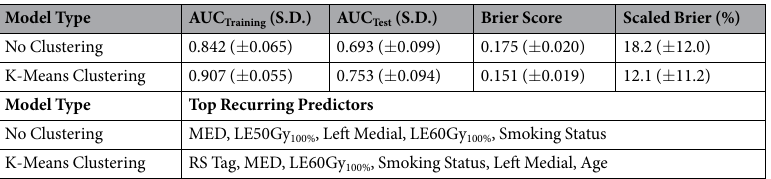
Table 3. Results of the lasso logistic regression toxicity prediction model construction process with and without using K-Means clustering to identify radiosensitive patients, from expansion-response quantified at the end of radiation therapy, for a total of 126 study patients. S.D. – Standard Deviation. The highest recurring predictors from all 1000 iterations of the model construction process are listed from highest to lowest recurring. Standard deviation of AUC values are listed in